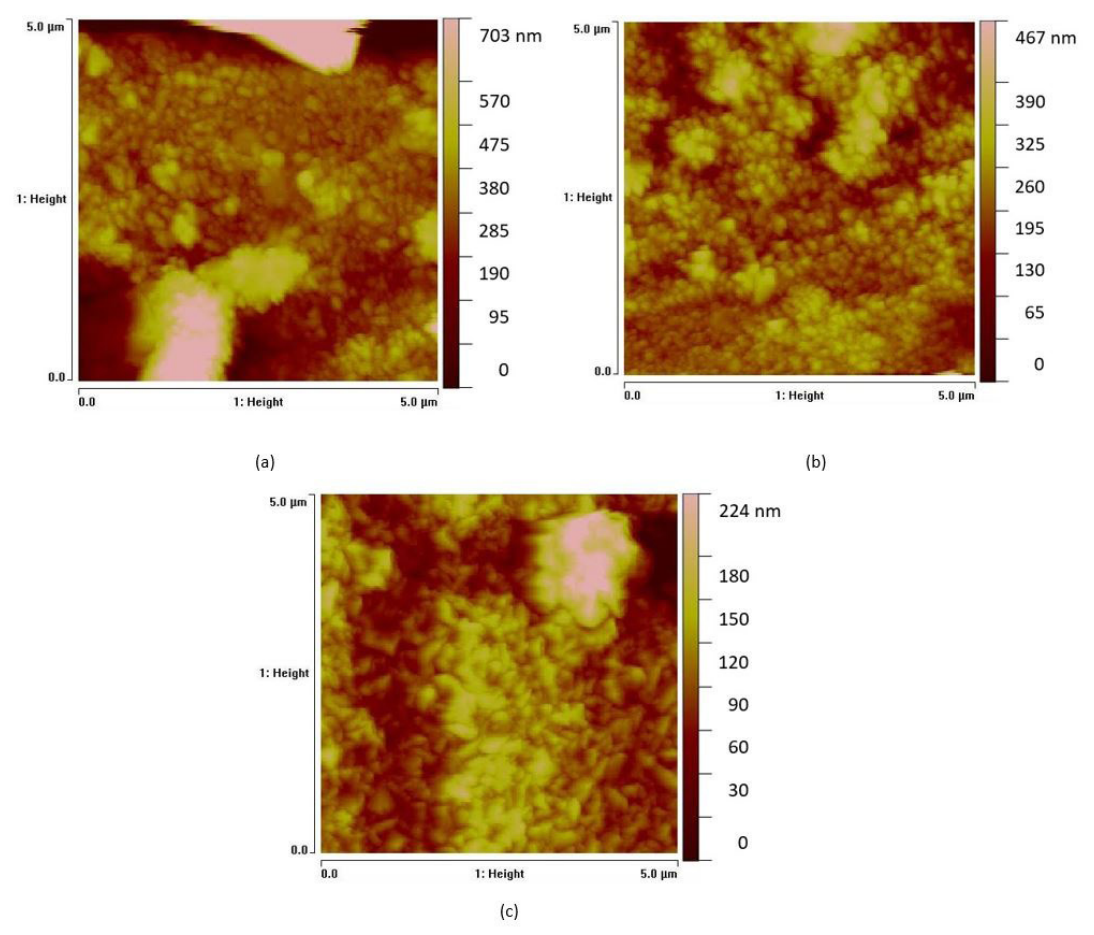
Figure 4. Topography of AZO coatings prepared at (a) 33%, (b) 43%, and (c) 50% argon partial pressure.